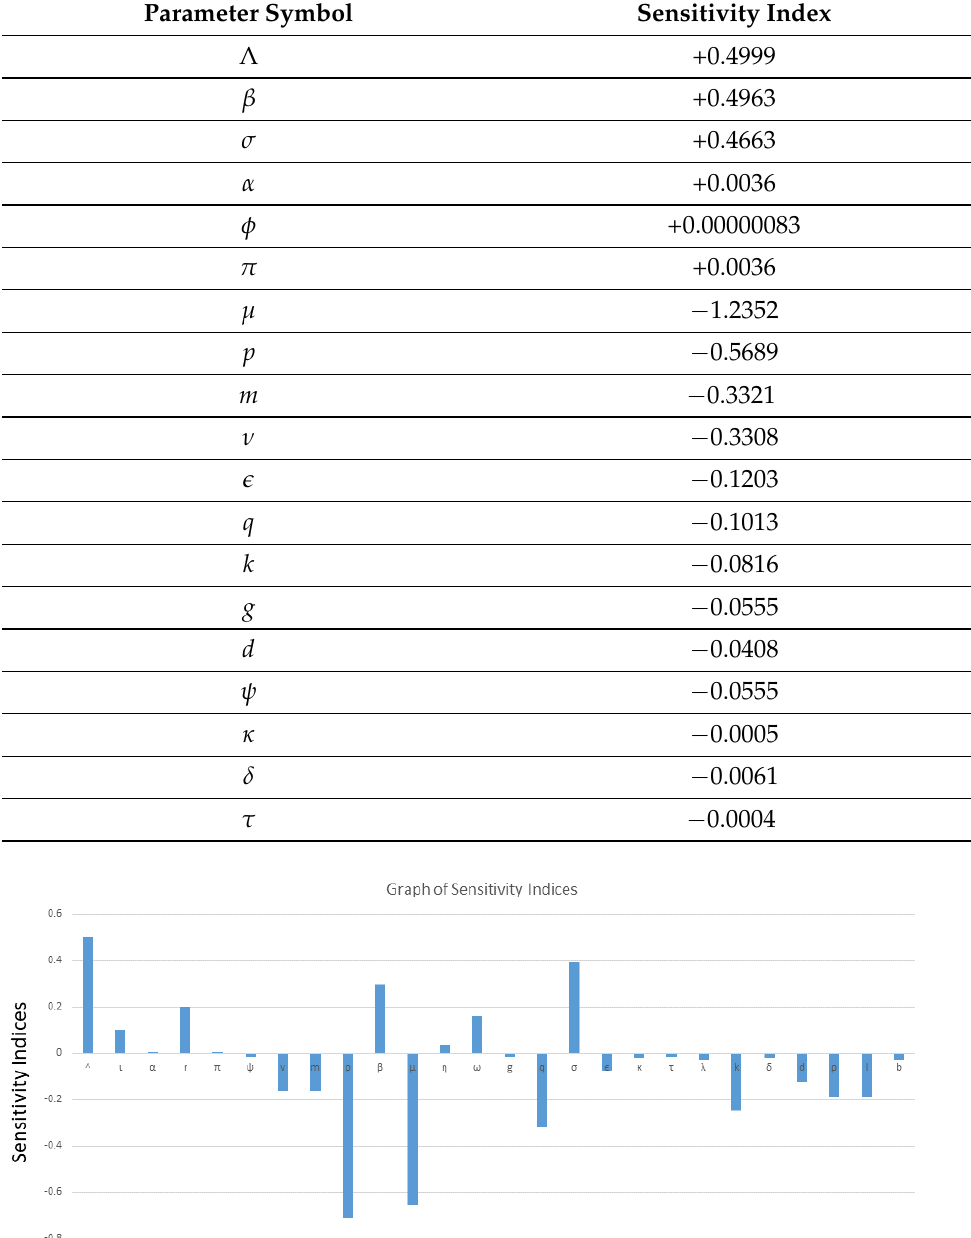
Table 3. Numerical values of sensitivity indices of R 0 with respect to parameter involved.